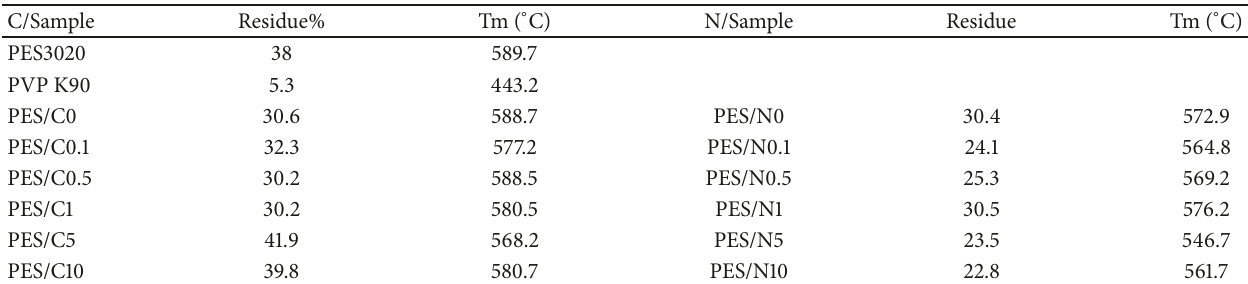
Table 4: Thermogravimetric (TGA) analysis measurements of PES/C and PES/N